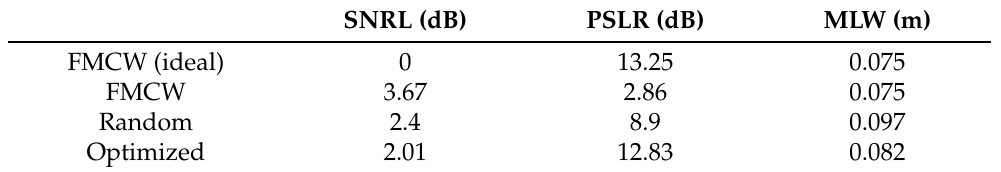
Table 3. Performance comparison with different waveform when jamming parameters are unknown.